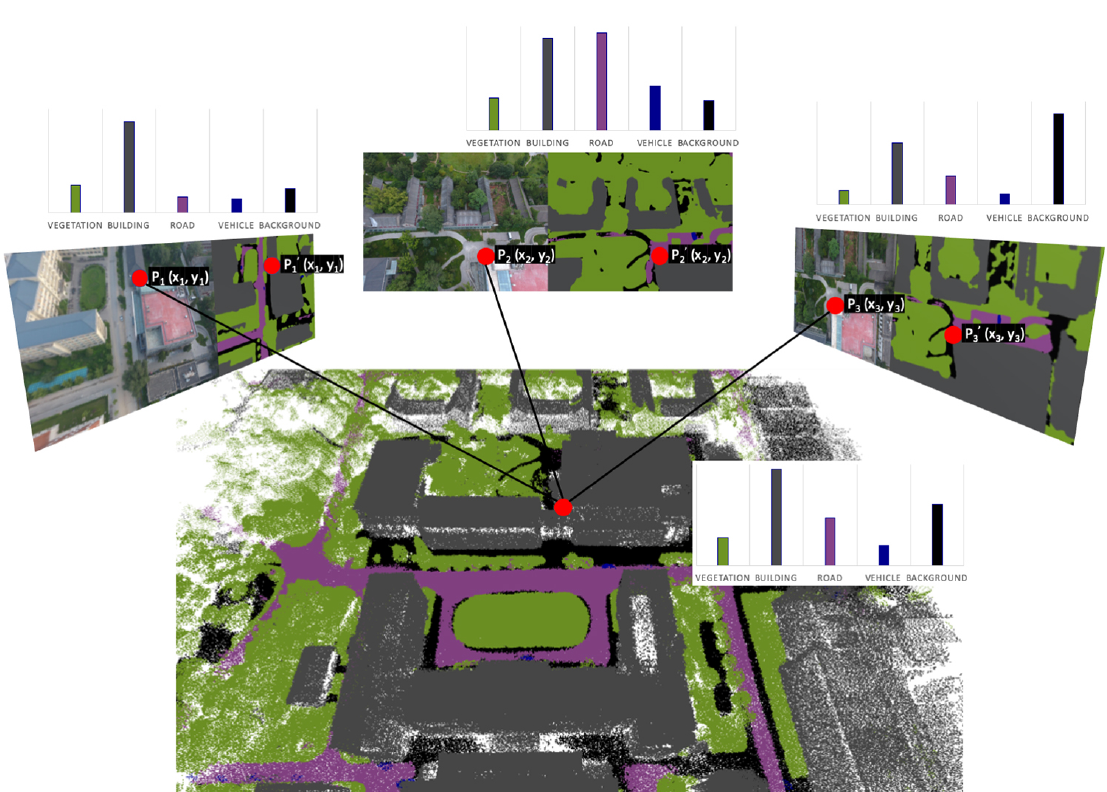
Figure 3. Illustration of our semantic fusion method: the 3D semantic labels are determined by multi-view information; the 3D point’s label is decided by the correspondence accumulated probability of 2D pixels in each